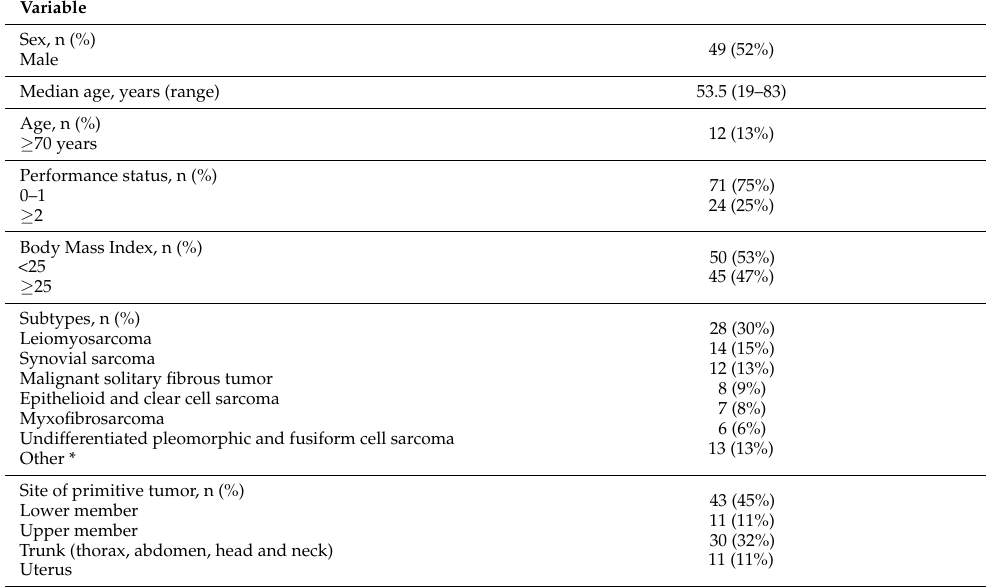
Table 1. Patient characteristics (n =